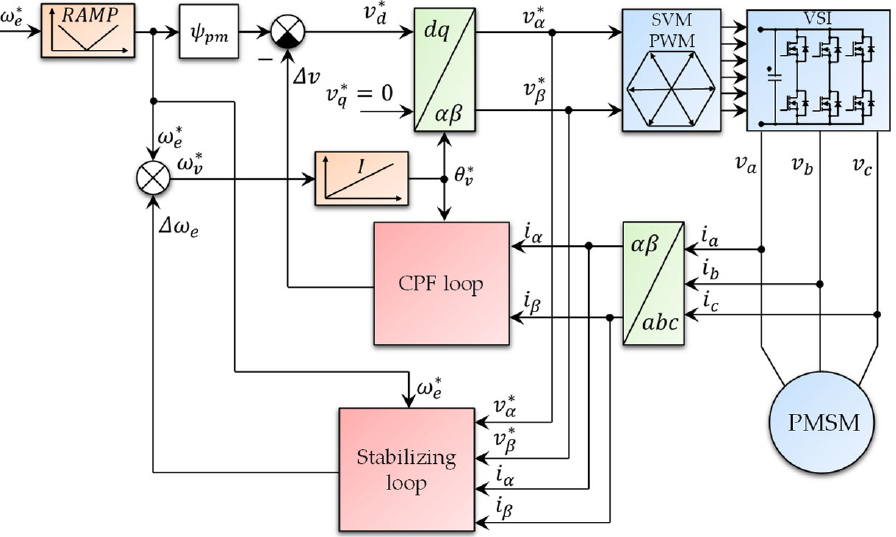
Figure 14. Block diagram of the stable V / f control with constant power factor loop.